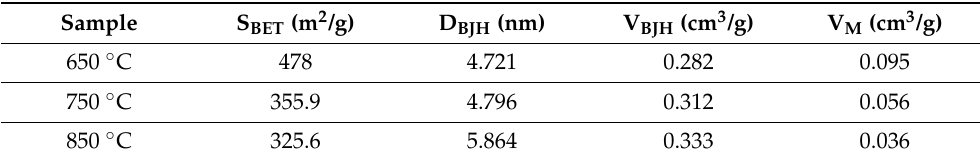
Figure 10. ( a ) N 2 adsorption-desorption isotherms curves and ( b ) pore size distribution at 650 ◦ C, 750 ◦ C, and 850 ◦ C. Table 3. Values of surface area (S BET ), total pore volume (V BJH ), pore diameter (D BJH ), and micropore volume (V M ) of three